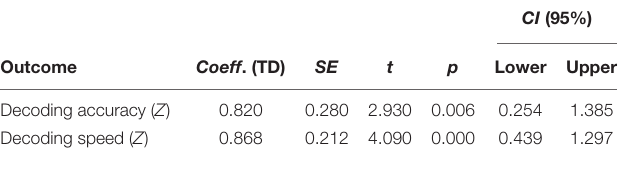
TABLE 1 | Differences between TD and DD children in standard measures of decoding accuracy and speed.